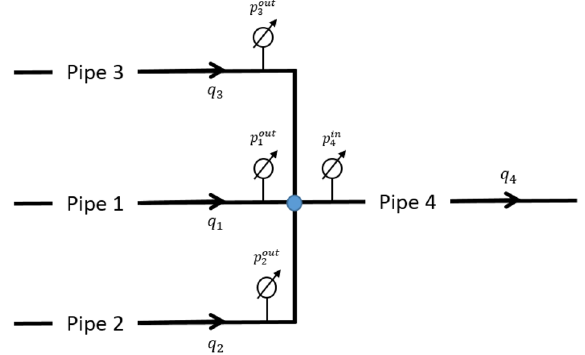
Fig. 7 Modeling of flow equilibria in a production network (after Hoffmann and Stanko 2017)